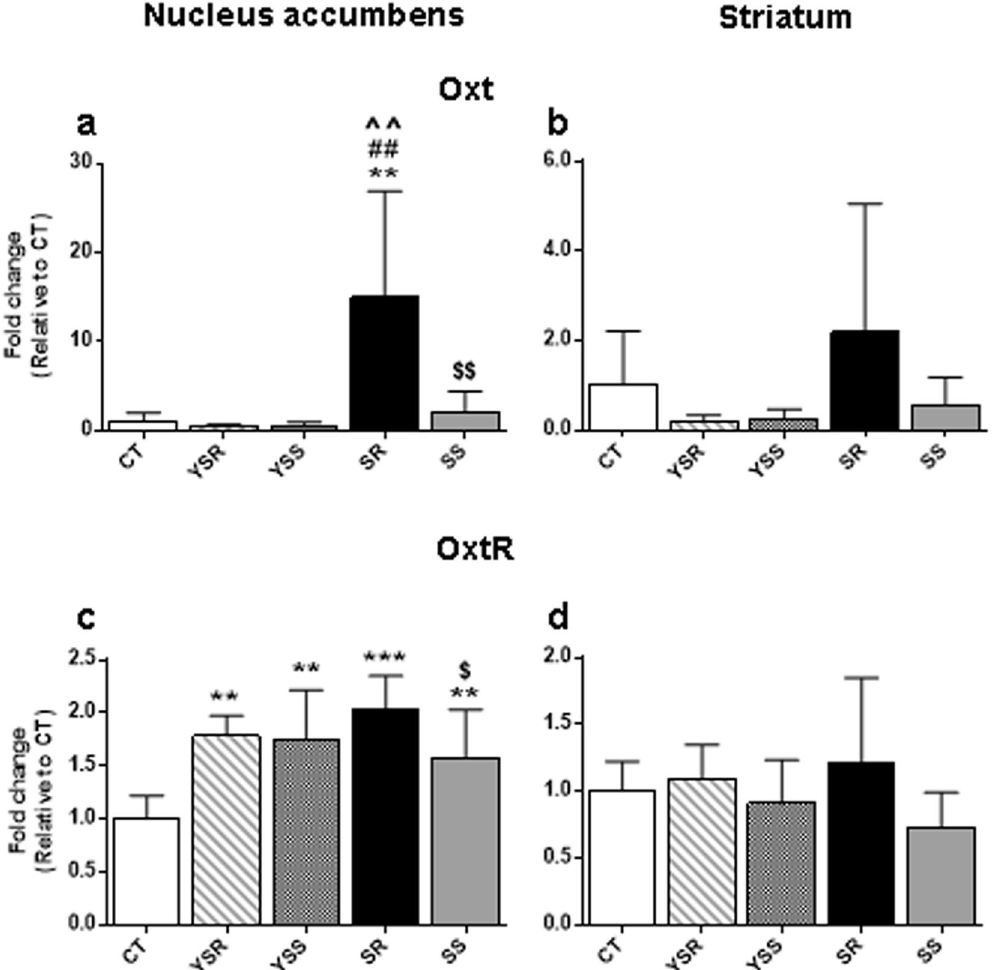
Figure 4. PCR validation of changes in oxytocin mRNA levels in the rat NAc after a month withdrawal from methamphetamine SA and footshocks. We conducted quantitative PCR using individual RNA from the NAc ( a , c ) and dorsal striatum ( b , d ) of rats from the various conditions (CT, n = 6–8; SR, n = 6–8; SS, n = 6–9; YSR, n = 3; YSS, n = 3–6). The shock-resistant rats showed significant increases in oxytocin ( a ) and oxytocin receptor ( c ) in the NAc but not in the dorsal striatum ( b and d , respectively). Values are means ± SEM fold changes relative to the control group. Key to statistics: ** p < 0.01, *** p < 0.001, in comparison to the control group; ##p < 0.01, in comparison to YSR rats; ^^p < 0.01, in comparison to the YSS group; $ p < 0.05, $$ p < 0.01 in comparison to the SR